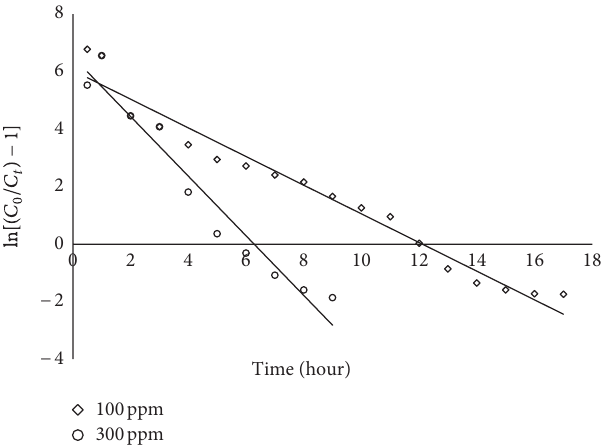
F 10: omas plot for the adsorption of Cr(VI) ions on